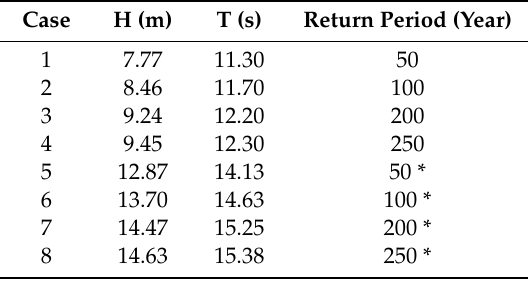
Table 2. The wave conditions (including return period of typhoon wave and extreme condition).